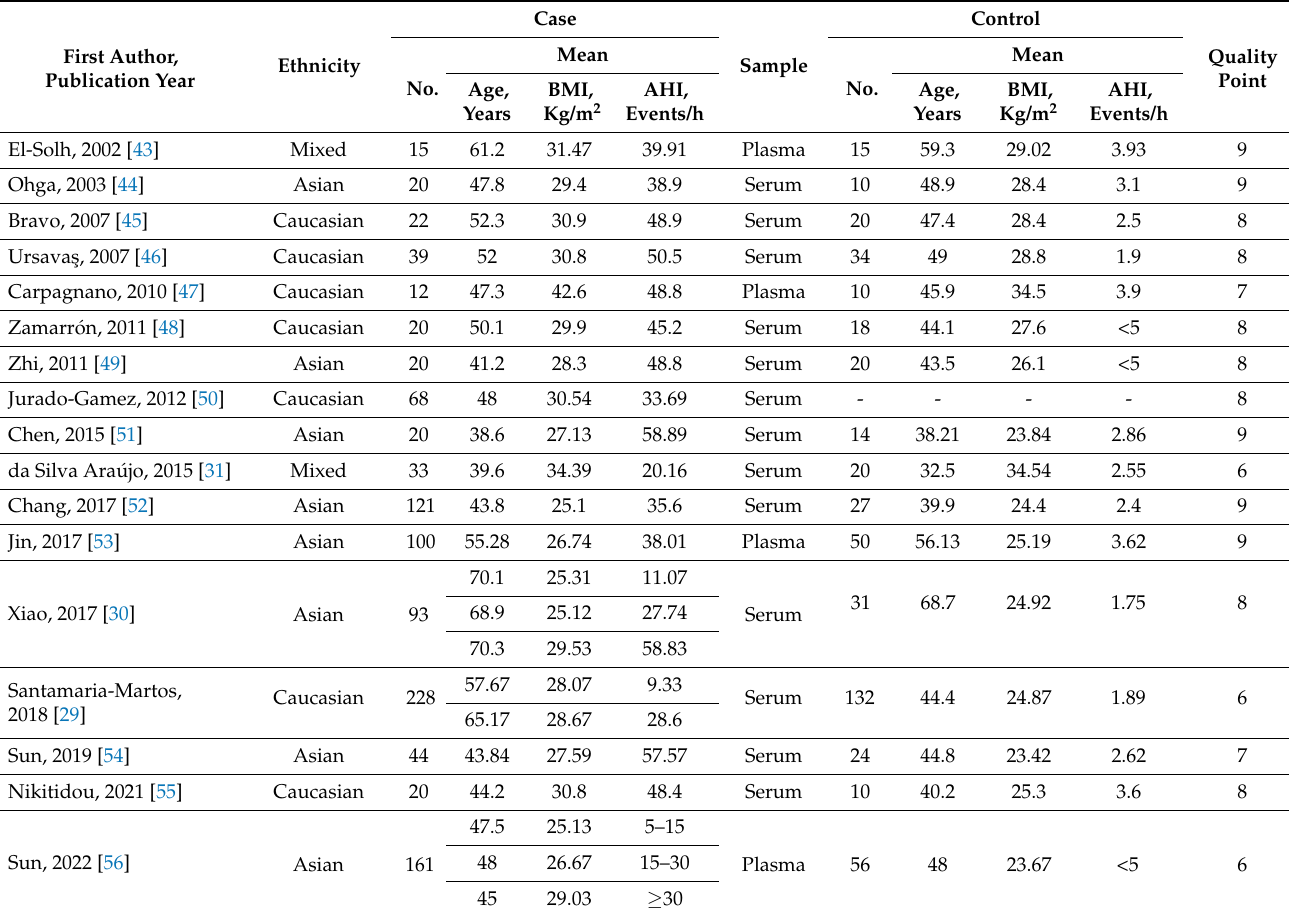
Table 1. Characteristics of articles included in the